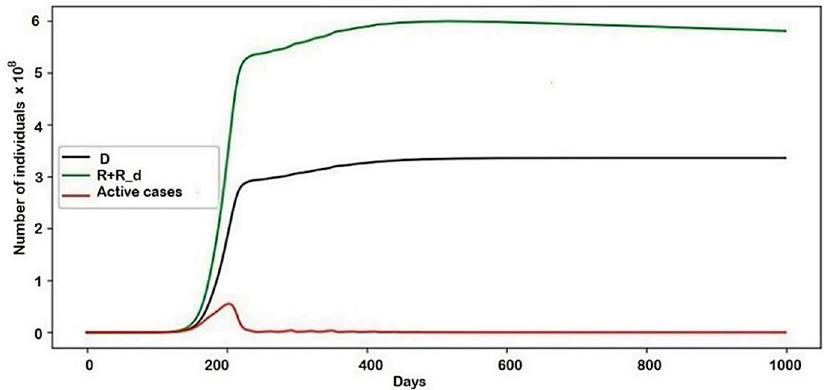
Figure 4. The behavior of the system in general.